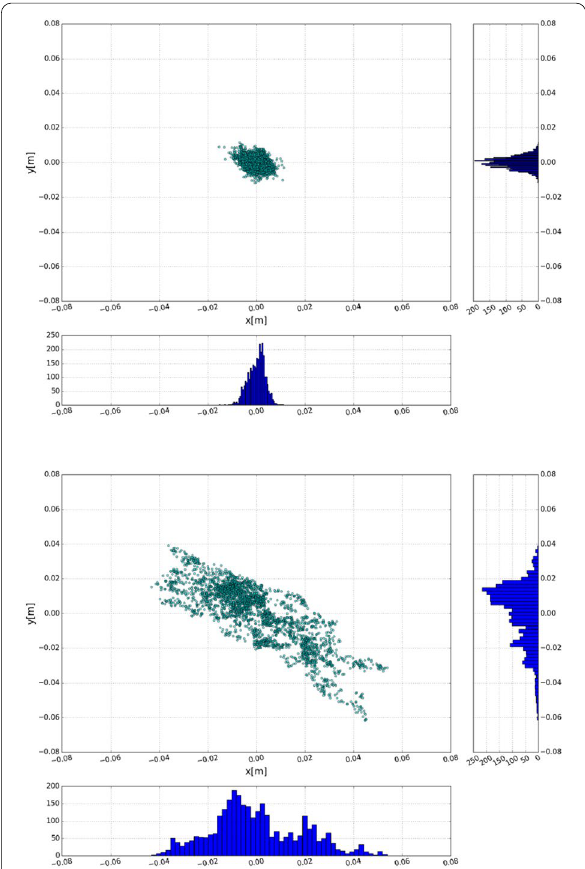
Fig. 8 Distribution of positioning data of the RTK-GPS (upper graph) and the QZSS (lower graph). The right-hand side panels and the lower panels of each graph show the histograms for each of the corresponding axes